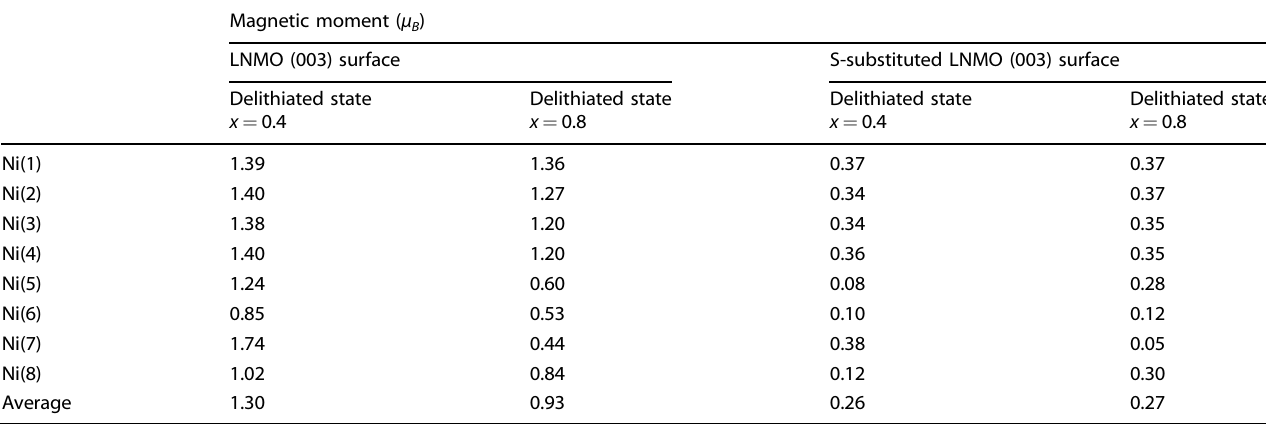
Table 2. Calculated magnetic moment for Ni atoms in the pristine and S-substituted LNMO (003) surfaces at delithiated state of x = 0.4 and